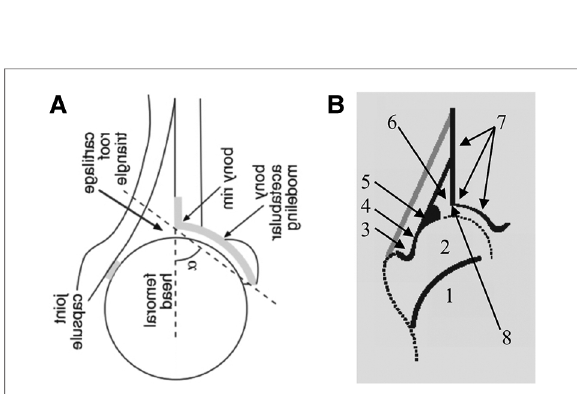
FIGURE 2 Schematic of the systematic evaluation of hip sonograms of different original articles ( A ). The original diagram from (5) was rotated by 90° and mirrored around the transversal axis for better clarity (ultrasound from the left, upright image). ( B ) Scheme of anatomical identi fi cation (Checklist I) from a course manual for the ultrasound course according to Graf (6). The numbers describe: 1, ChB (chrondro-osseous border); 2, femoral head; 3, synovial fold; 4, joint capsule; 5, labrum; 6, cartilage; 7, bony roof; 8, bony rim (turning